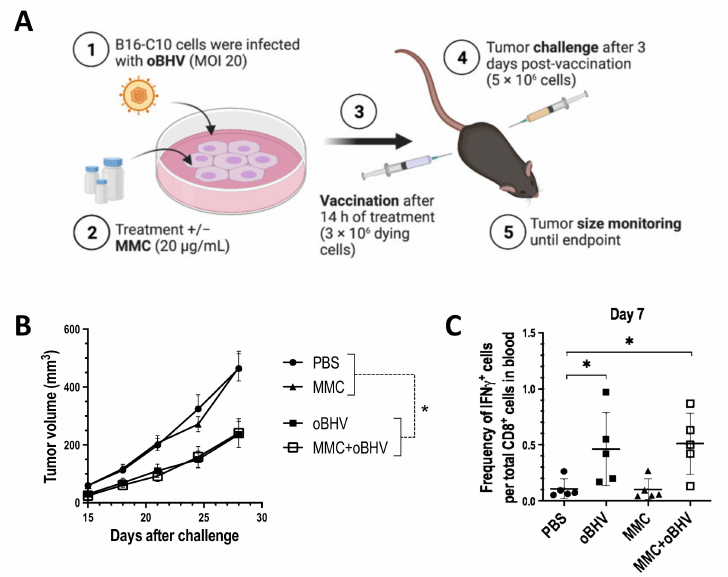
Figure 2. ( A ) B16-C10 cells were mock- or infected with oBHV (1) and, after 2 h, they were treated with or without MMC (2). After 14 h incubation, dying cells were used to vaccinate mice (3) and, 3 days later, untreated B16-C10 cells were implanted (challenge) (4). (5) Tumor volumes were measured from day 15 after challenge every 3–4 days until endpoint. ( B ) Tumors volume mean ± SEM. ( C ) On day 7, blood was collected for IFN γ intracellular staining of CD8+ T cells stimulated with tumor-specific peptides. * p <